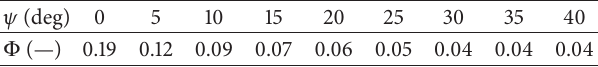
Table 1: Values of the objective function in different positions. 𝜓 (deg) 0